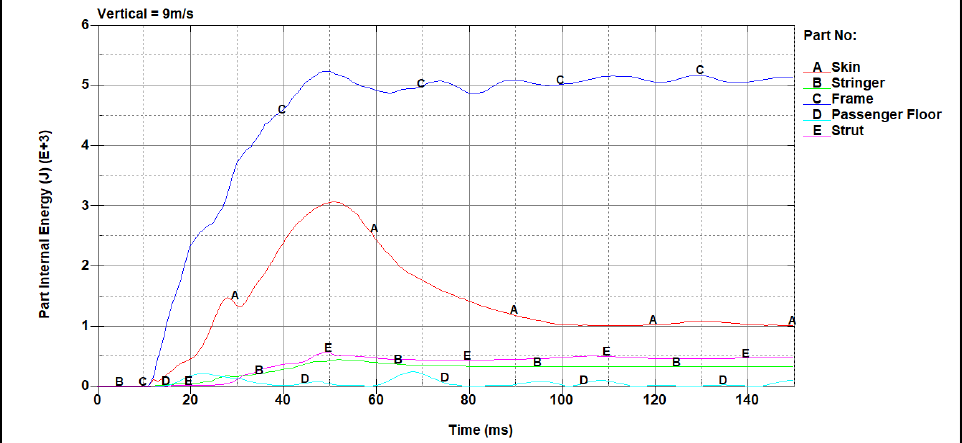
Figure 3: Internal energy absorbed by each component of aluminium